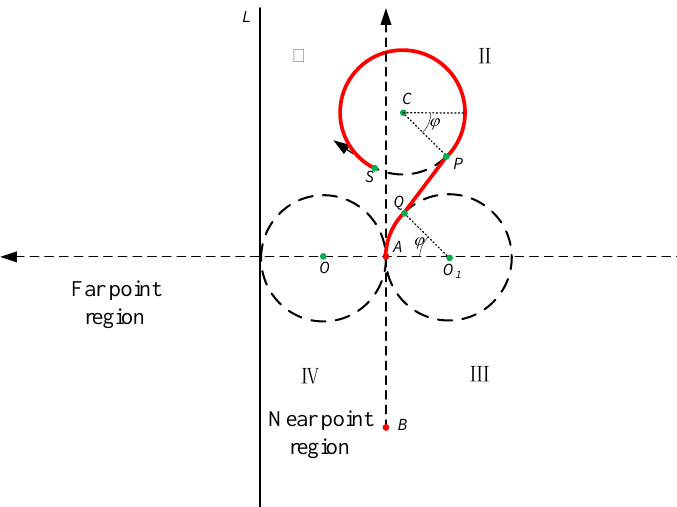
Figure 7. Route 3 in the near point region.